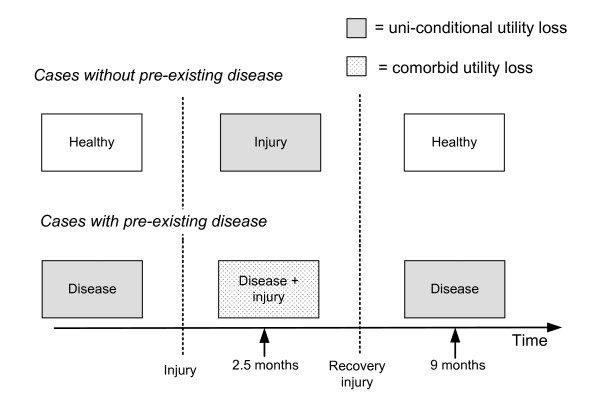
Design of the study.